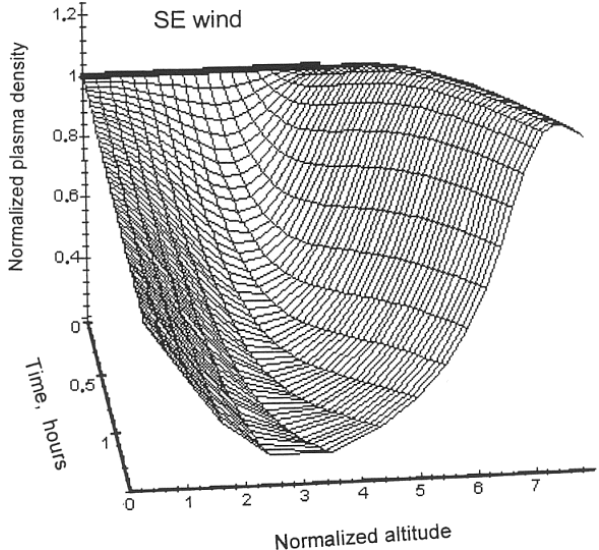
Fig. 8. Same as Fig. 5 but for the southwest PW vortex quadrant, i.e. the profile here is representative of PW wind pointing SE. Here, both vertical forces act to push the ionization out to higher altitudes, thus creating a depletion in the lower